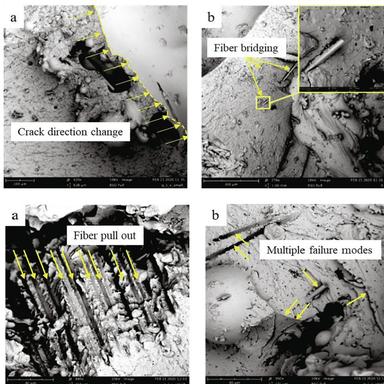
Fracture mechanisms in the small pyramids samples. a) crack direction changes b) fiber pullout c) fiber bridging and d) combination of previous mechanisms.